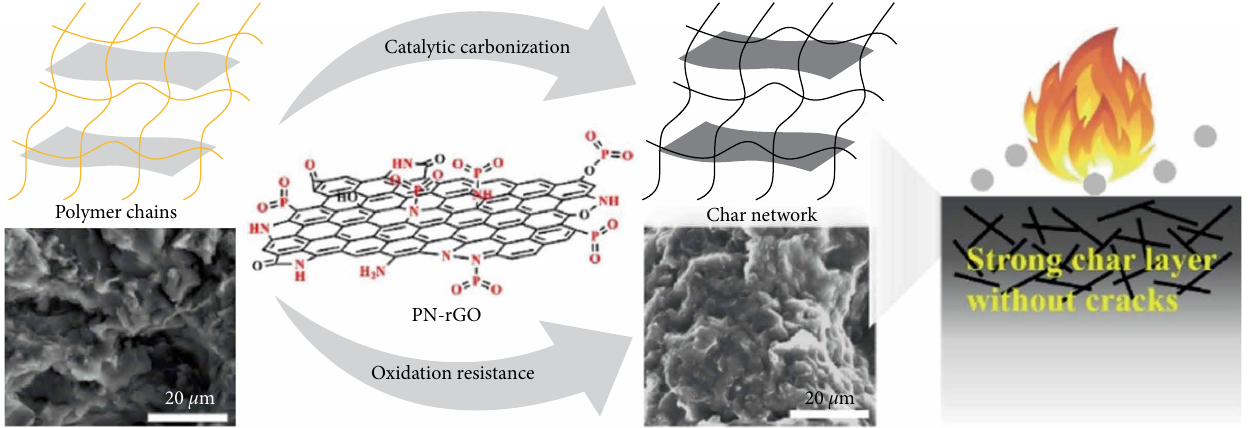
Figure 8: Schematic illustration of PN-rGO improving oxidation resistance of the char layer and catalytic carbonization capacity for EP chains. Adapted from